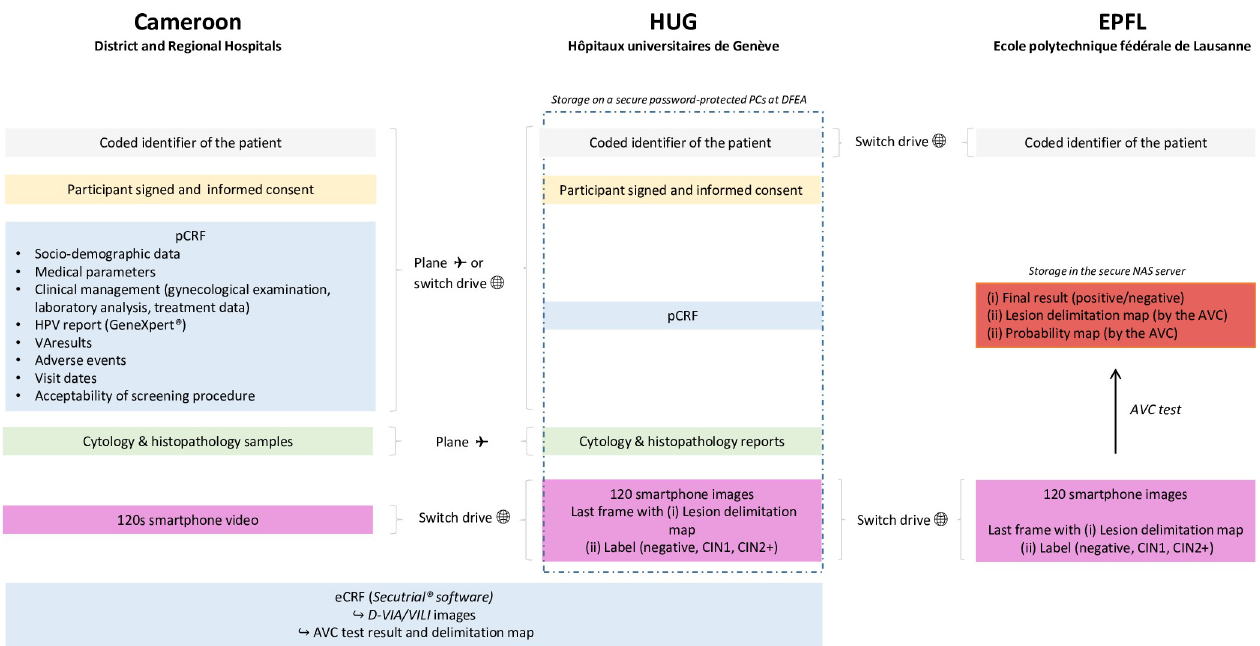
Fig 3. 3T study data management plan. Cameroon: participants will be pseudonymized with an identification key consisting of a code number and the participant’s initials. A paper Case Report Form (pCRF) will be created for each research subject: it will contain its personal, medical and screening-related information. These data will also be electronically stored (eCRF) in a RDBMS (Relational Database Management System) using a dedicated CDMS software (Clinical Database Management System) called secuTrial 1 . This software will also be used to save VA images, AVC test results and delimitation maps. University Hospitals of Geneva: a secure password-protected PC at the Department of Pediatrics, Gynecology and Obstetrics (DFEA) will store all collected data (dashed rectangle) and eCRFs will be accessible on secuTrial 1 . Data management will be performed by the Unit of Clinical Investigation (UIC), a unit which is part of the Clinical Research Center (CRC) at HUG as well as by designated research assistants at the DFEA. Cytological and histopathological samples will be transported by aircraft and analyzed at the Division of Clinical Pathology of the HUG, in conformity with Swiss standards and international recommendations. Smartphone videos will be shared by SWITCH drive (https : //www . switch . ch/drive/) in the form of 120 frames. The last frame will be labelled by a colposcopy specialist of HUG who will also manually delimitate any visible lesion. EPFL: Final results (positive/negative), lesion delimitation maps and probability maps (PNG format) obtained during the AVC test will be stored in a secure NAS server in